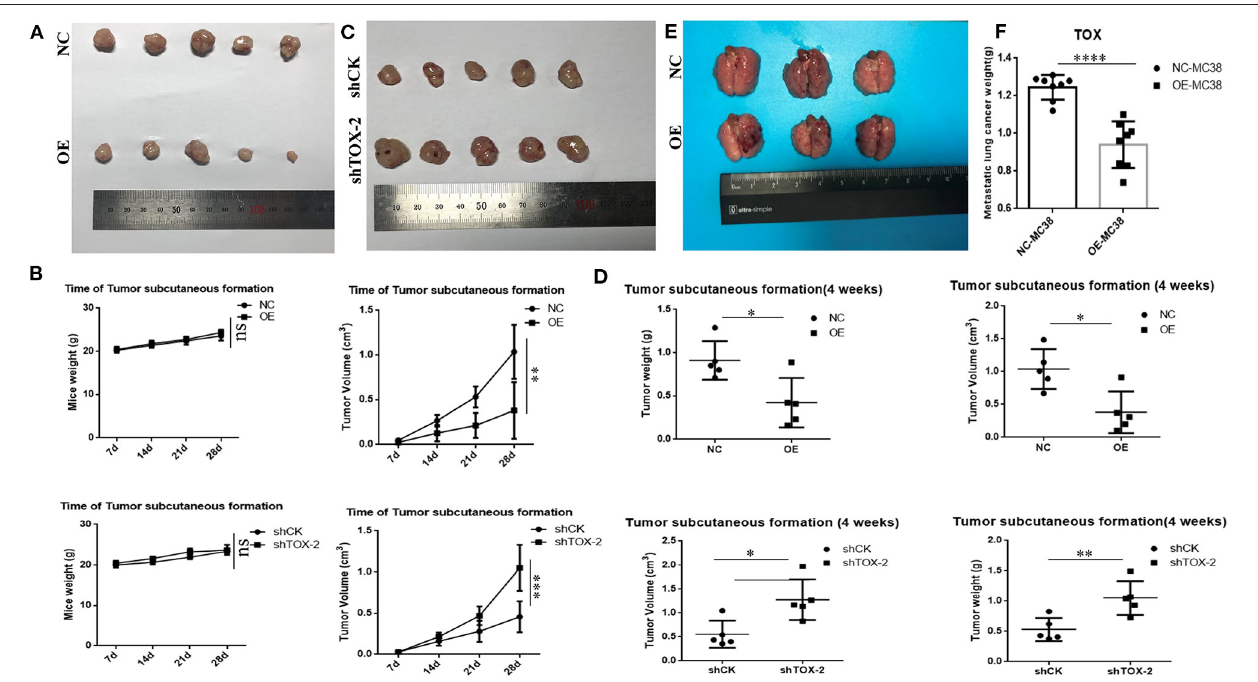
FIGURE 6 | TOX acts as a tumor suppressor by inhibiting tumorigenesis and metastasis in vivo . (A) Tumor samples of PLVX-Flag SW1116 (negative control, NC) and PLVX-Flag-TOX SW1116 (overexpression, OE) cells were shown (4 weeks). (B) Bodyweight and tumor volume of NC and OE group were shown. (C) Tumor samples of GFP-shCK HCT116 and GFP-shTOX-2 HCT116 cells were shown (4 weeks). (D) Bodyweight and tumor volume of GFP-shCK HCT116 and GFP-shTOX-2 HCT116 group were shown (E) Lung metastasis sites of injecting with PLVX-Flag MC38 and PLVX-Flag- Tox MC38 cells were shown (3 weeks). (F) Lung weights of injecting with PLVX-Flag MC38 or PLVX-Flag- Tox MC38 cells were shown (3 weeks). * p < 0.05,** p < 0.01,**** p < 0.0001, ns: not